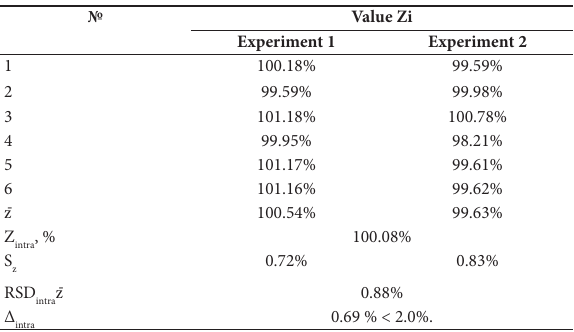
Table 11. Robustness data of the